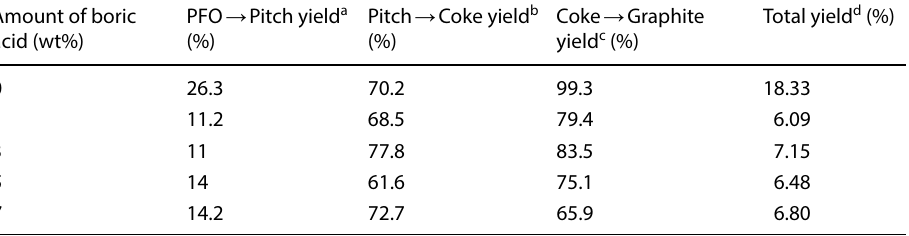
Table 2 Coking yield of each heat treatment process